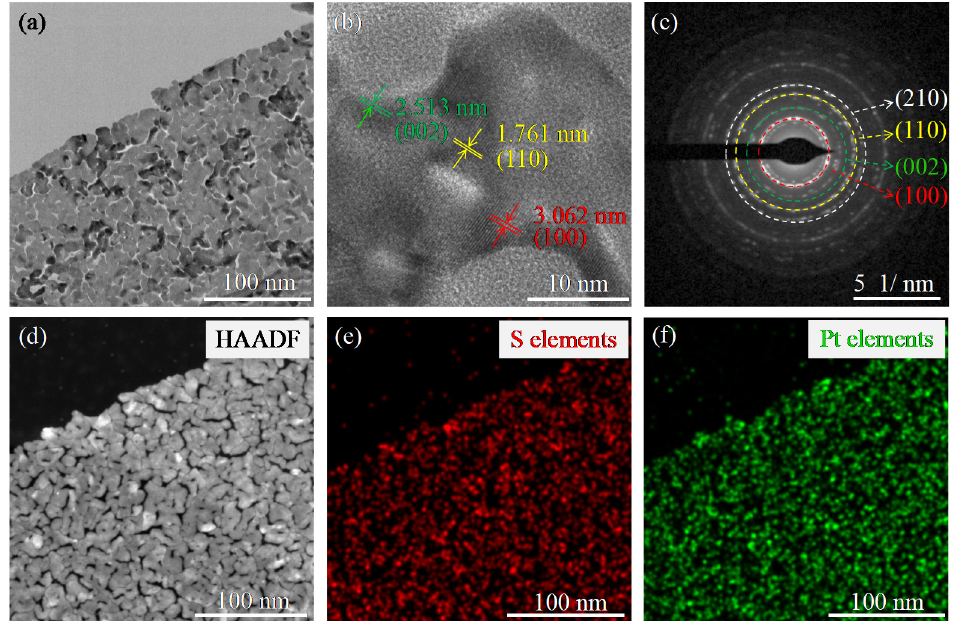
Figure 2. Characterization of crystal structure and quality of as-grown PtS 2 films. ( a , b ) HRTEM image of PtS 2 films. ( c ) The corresponding selected area electron diffraction pattern of PtS 2 film. ( d ) HAADF-STEM image of PtS 2 films. ( e , f ) EDS elemental mapping images of PtS 2 film.